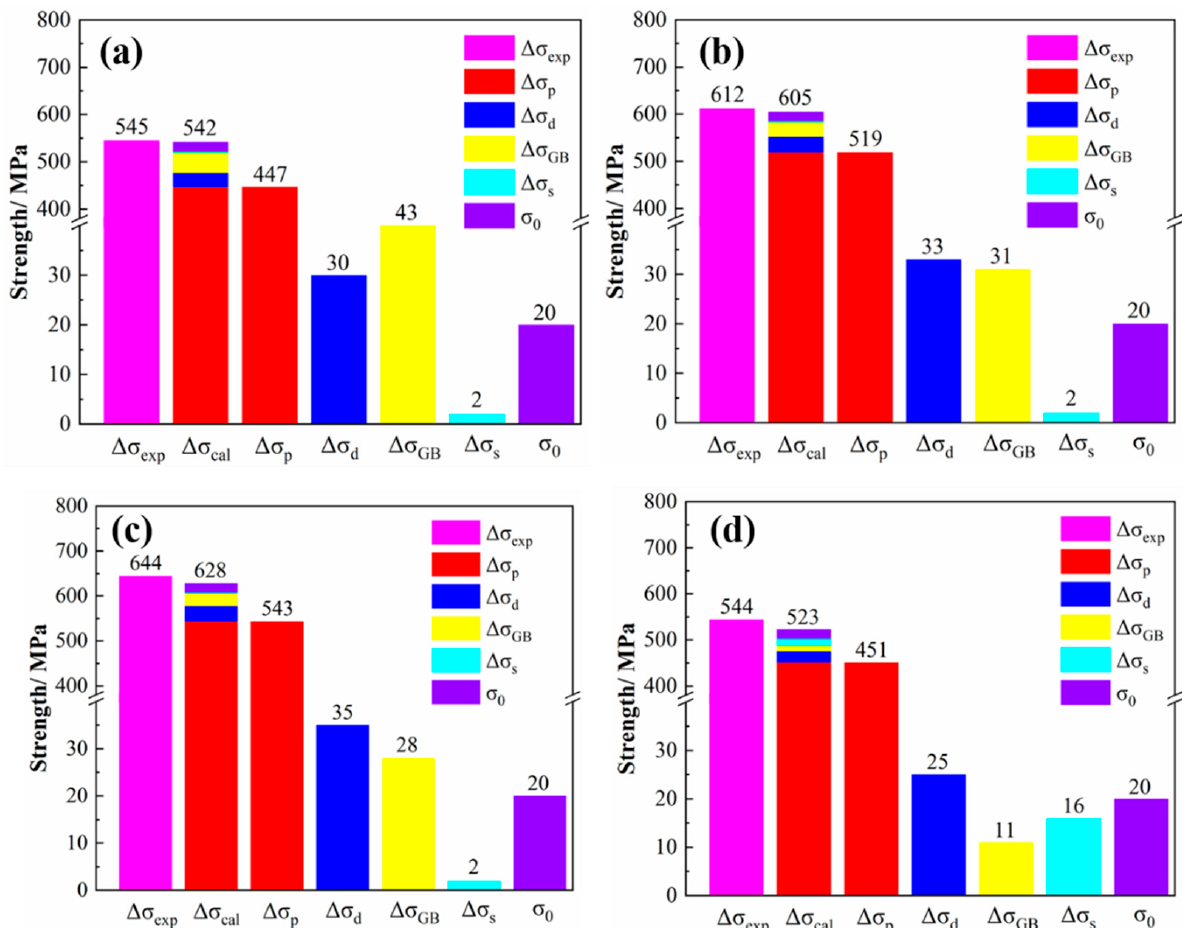
Figure 8. Experimental and theoretical results of yield strength of tested alloys. ( a ) NC-1 alloy; ( b ) NC-2 alloy; ( c ) NC-3 alloy; ( d ) NC-4 alloy.